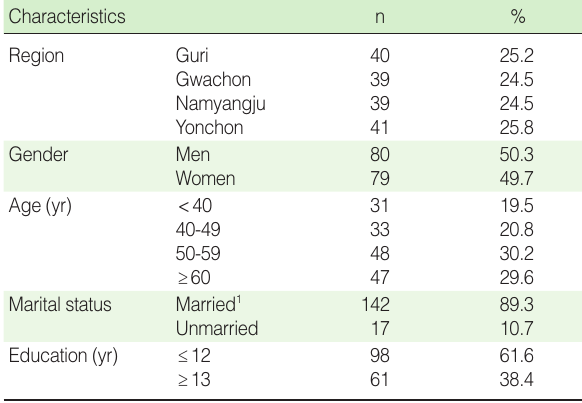
Table 1. Demographic characteristics of the respondents Characteristics